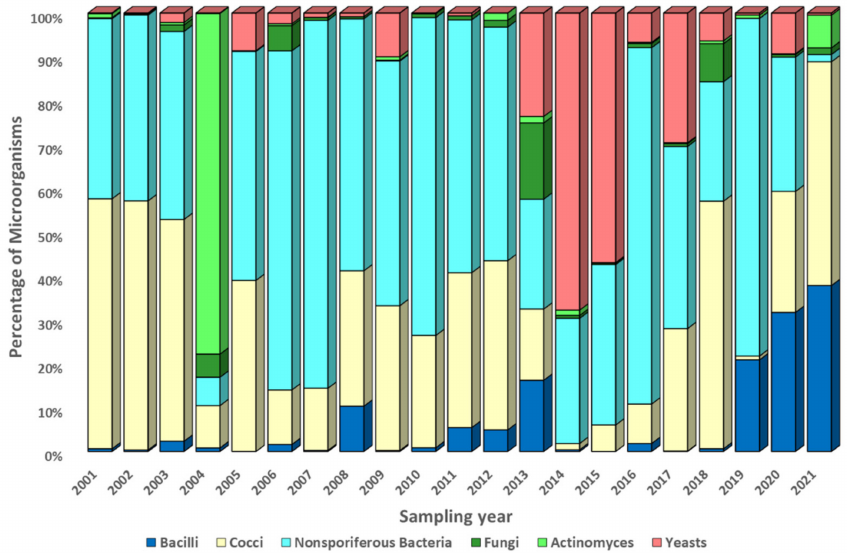
Figure 7. Average annual variability of the ratio of culturable microorganisms in samples taken at the site in the village of Klyuchi. Explanations in the